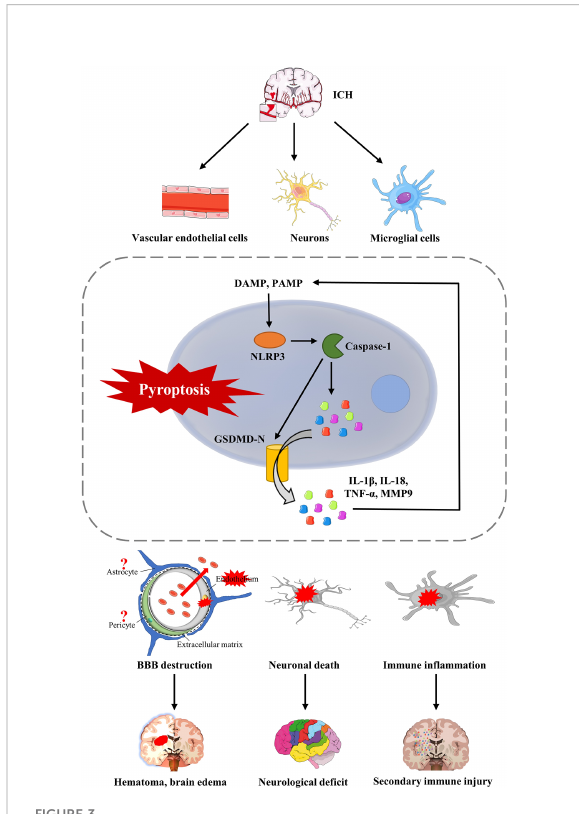
FIGURE 3 The consequences of pyrotosis after ICH. Pyroptosis of cerebral microvascular endothelial cells after ICH can lead to disruption of the BBB, further aggravated by the formation of hematoma and brain edema. Furthermore, pyroptosis, which occurs in neurons, leads to the death of functional neurons, which is a fundamental cause of neurological impairment and complications after ICH. Furthermore, pyroptosis of microglia after ICH will release various in fl ammatory factors, such as IL-1 b , IL-18, and TNF- a , and recruit more extracellular in fl ammatory factors, leading to secondary immune